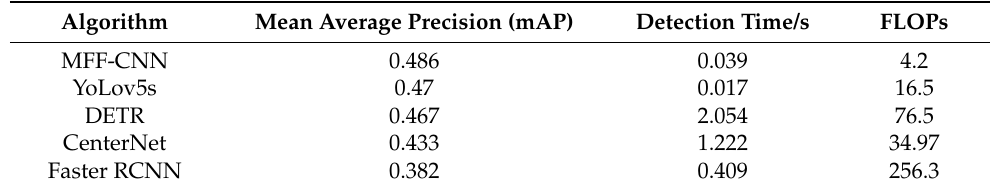
Table 2. Comparison of mAP, detection time, and